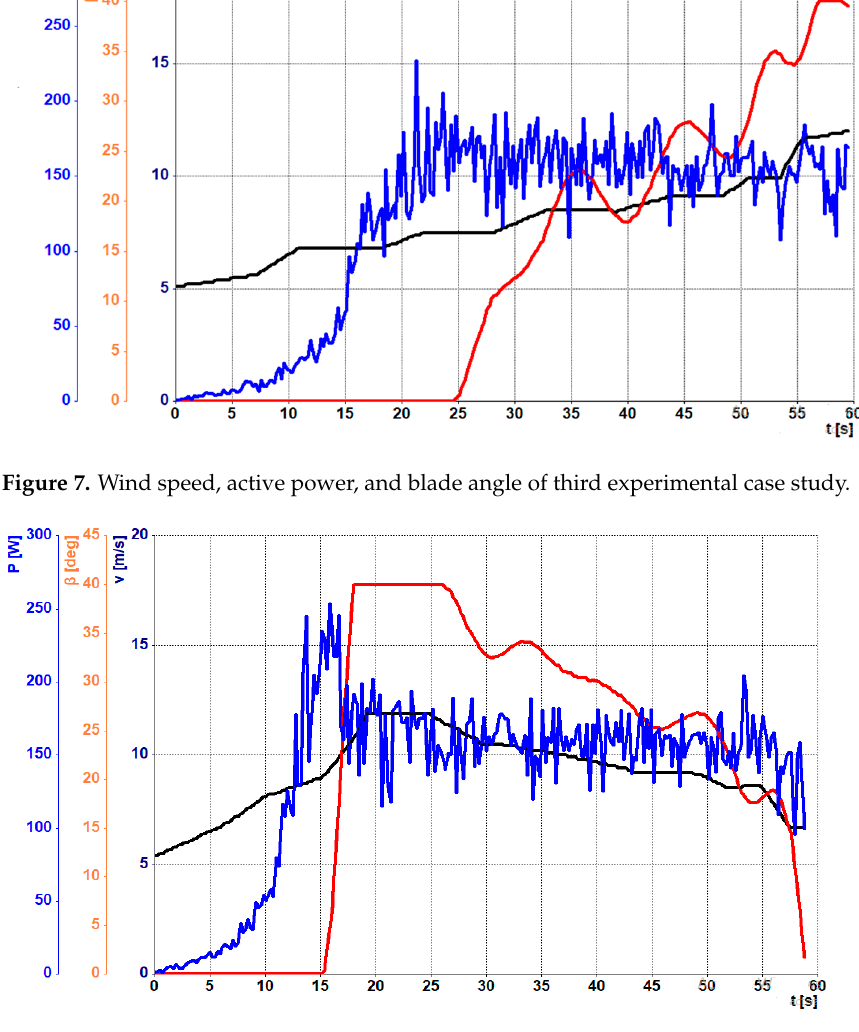
Figure 8. Wind speed, active power, and blade angle of fourth experimental case study.